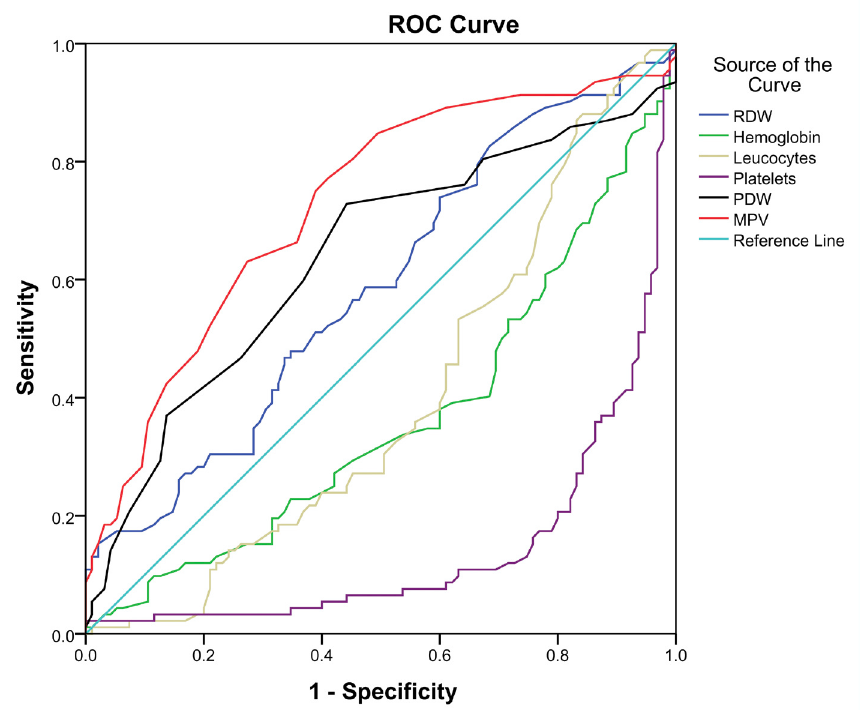
Figure 1. Receiver operating characteristic (ROC) curve and the associated reliability of blood parameters in predicting malaria in eastern Sudan.